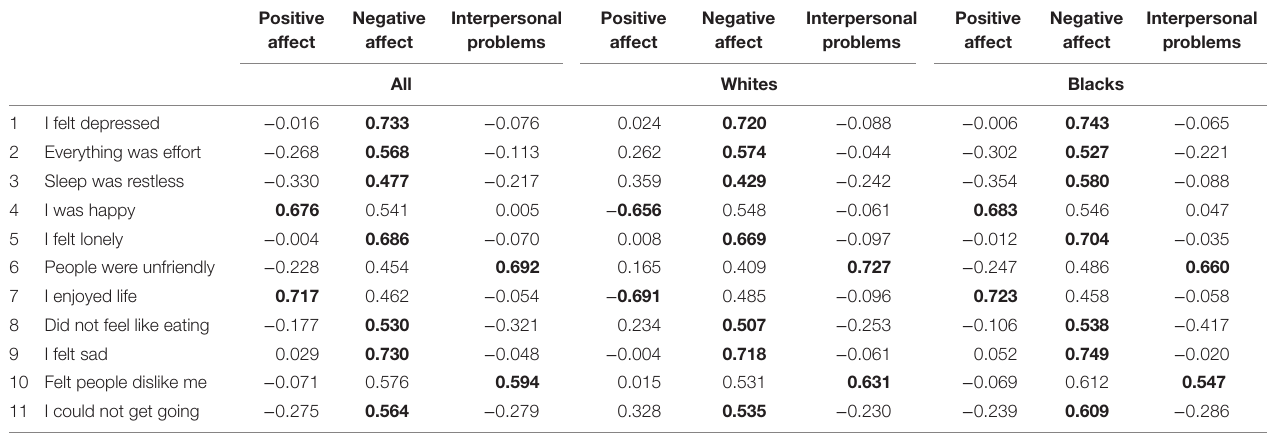
CES-D; Center for Epidemiologic Studies Depression scale. Extraction method: principal component analysis. Bold numbers show items that are loaded in each